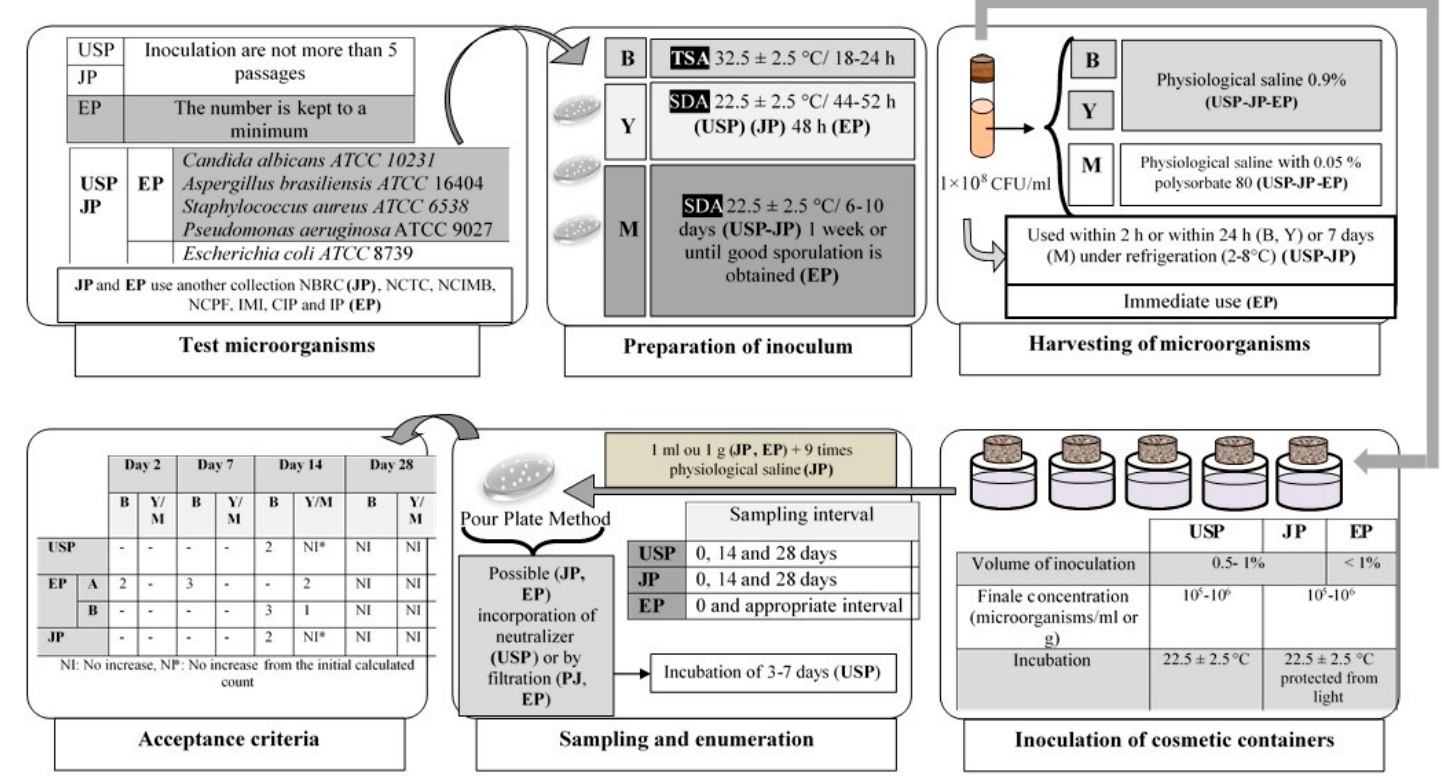
Figure 2. Preservative effectiveness testing comparison between the Japan, USA and European Pharmacopeias [38,108,109] where: B: bacteria, Y: yeast, M: molds, USP: United States pharmacopeia, JP: Japanese pharmacopoeia, EP: European pharmacopoeia, TSA: soybean-casein digest agar, and SDA: sabouraud dextrose agar.